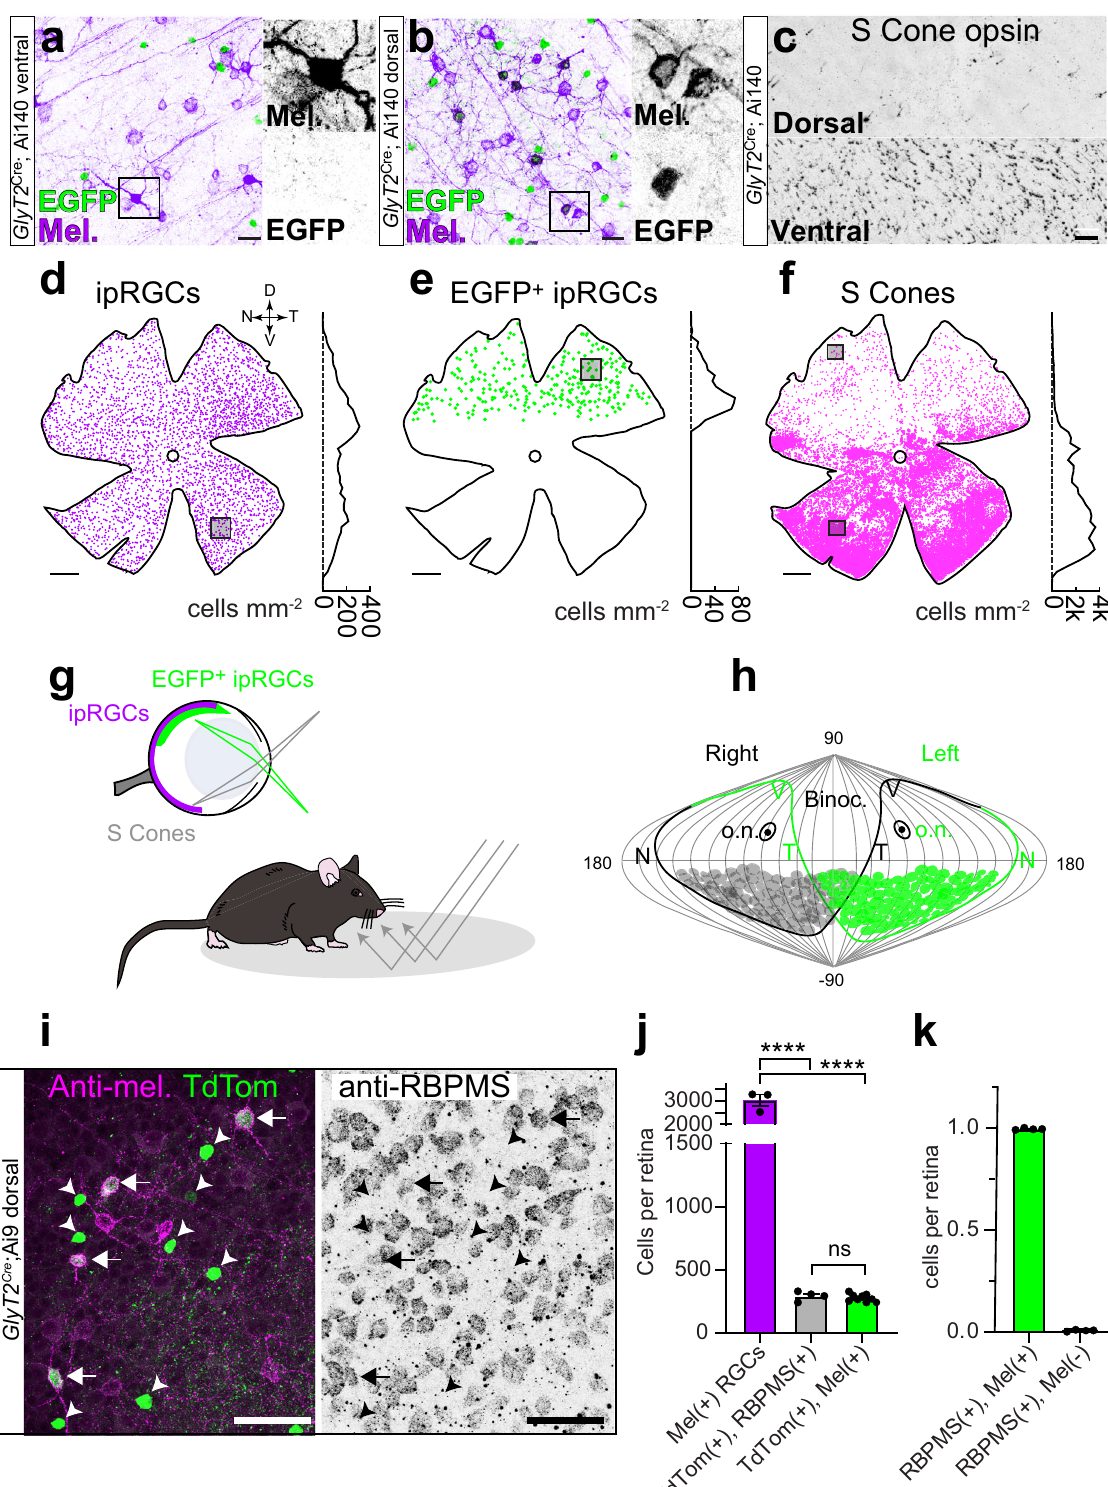
M1 ipRGCs in the dorsal and ventral retinas should be the same if we discount the GlyT2 Cre M1 ipRGCs. To test this hypothesis, we examined the retinal distribution of all M1 ipRGCs using confocal microscopy of melanopsin stained GlyT2 Cre ;Ai140 retina taking advantage of their strati fi cation in the IPL (Fig. 4a – c) and high melanopsin expression (Fig. 4c) 28,33 . Whole retina density maps of M1 ipRGCs ( n = 698 ±30.8 cells; n =5 retinae from n =3 animals) con fi rm their increased dorsal